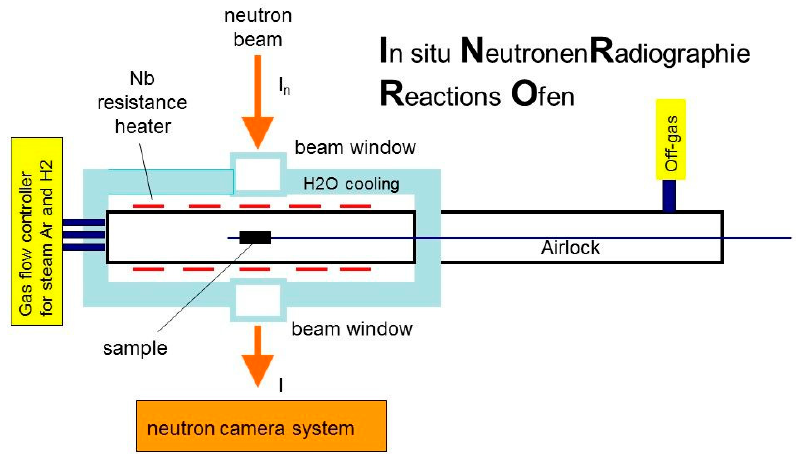
Figure 3. Scheme of the INRRO (in situ neutron radiography reaction oven) furnace of KIT.